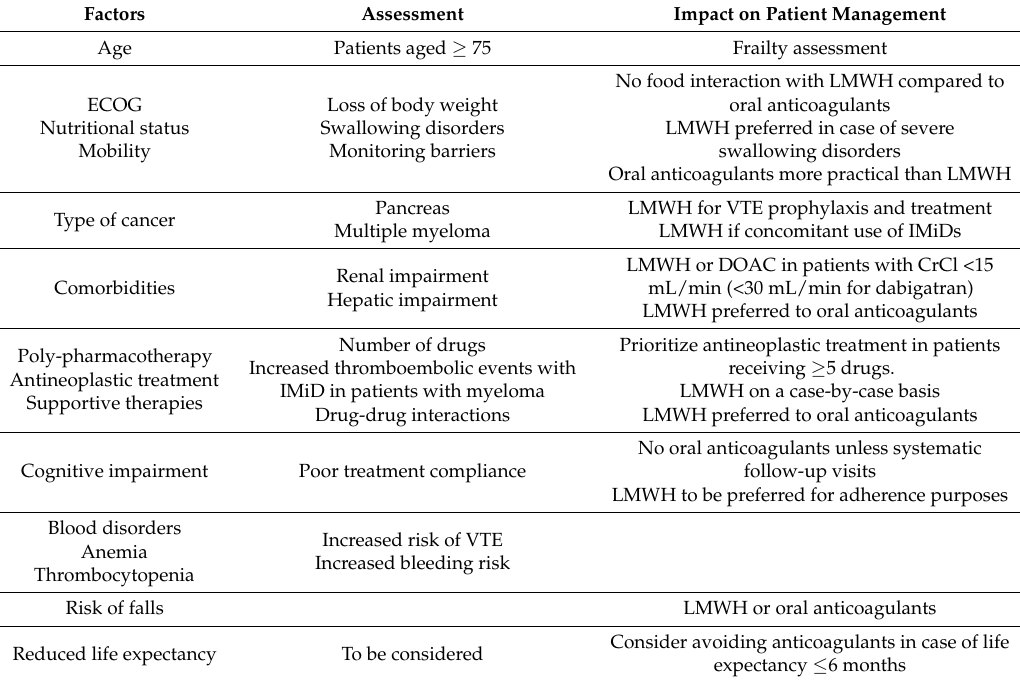
Table 3. Factors contributing to frailty in patients with cancer-associated thrombosis